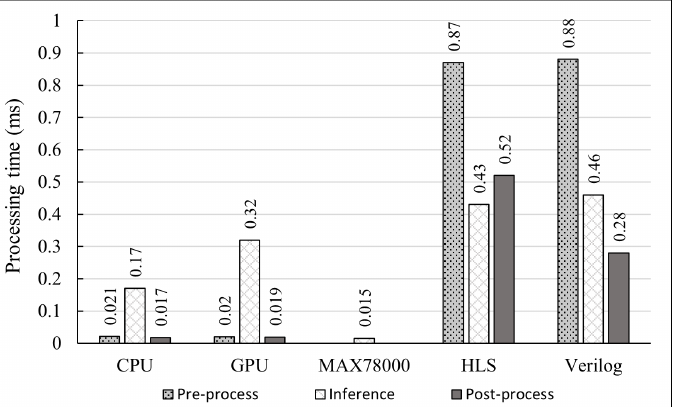
Figure 9. The pre-process, inference, and post-process time from different